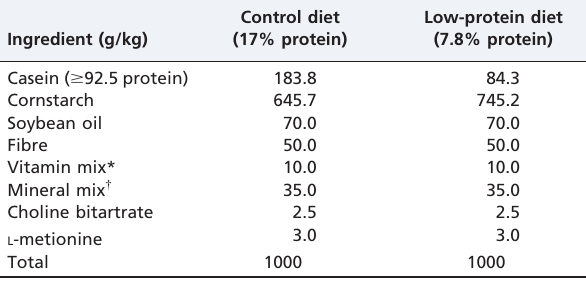
Table 1 - Composition of the experimental